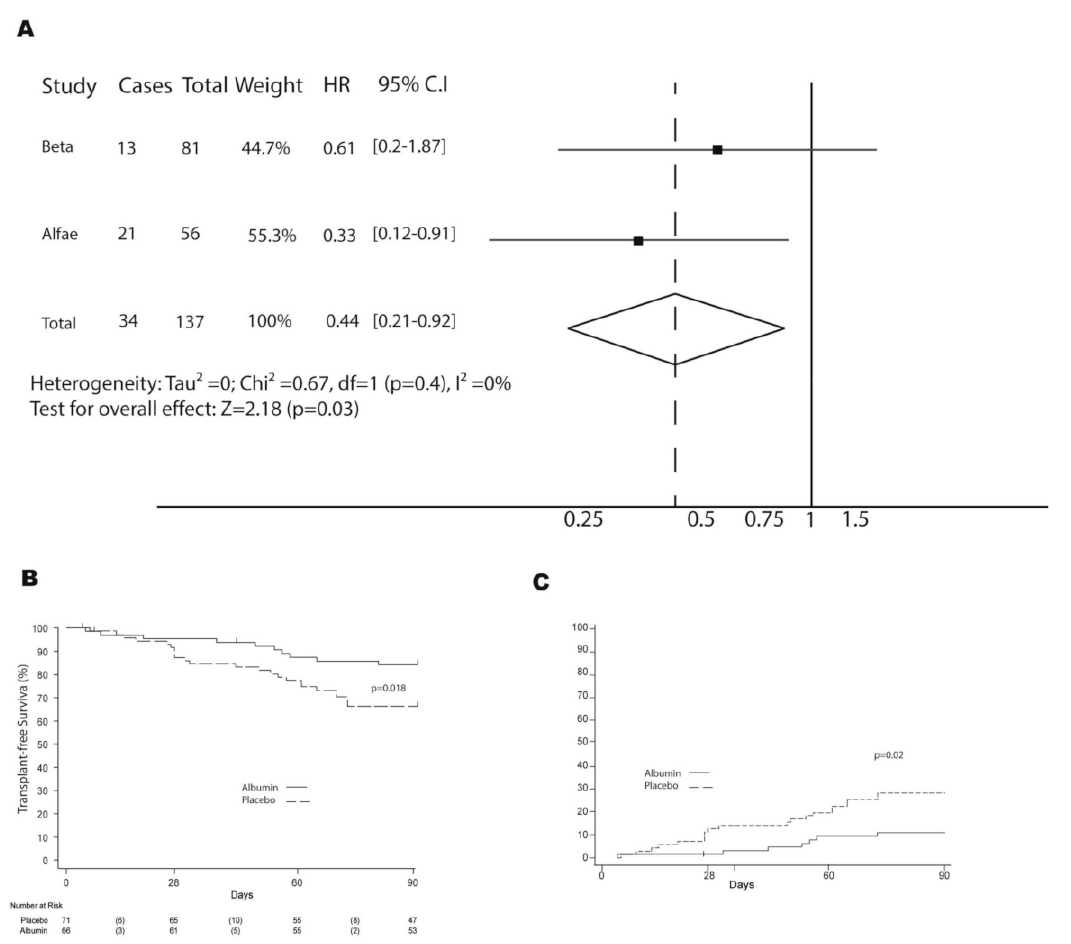
Figure 3. Forest plot of transplant-free survival and cumulative incidence of death with transplant as a competing risk for BETA and ALFAE studies. ( A ) Forest plot comparison of transplant-free survival; ( B ) Kaplan–Meier estimates of transplant-free survival at 90 days. ( C ) The 90–day cumulative incidence of death with transplant as a competing risk. Abbreviations: hazard ratio, HR; confidence interval,